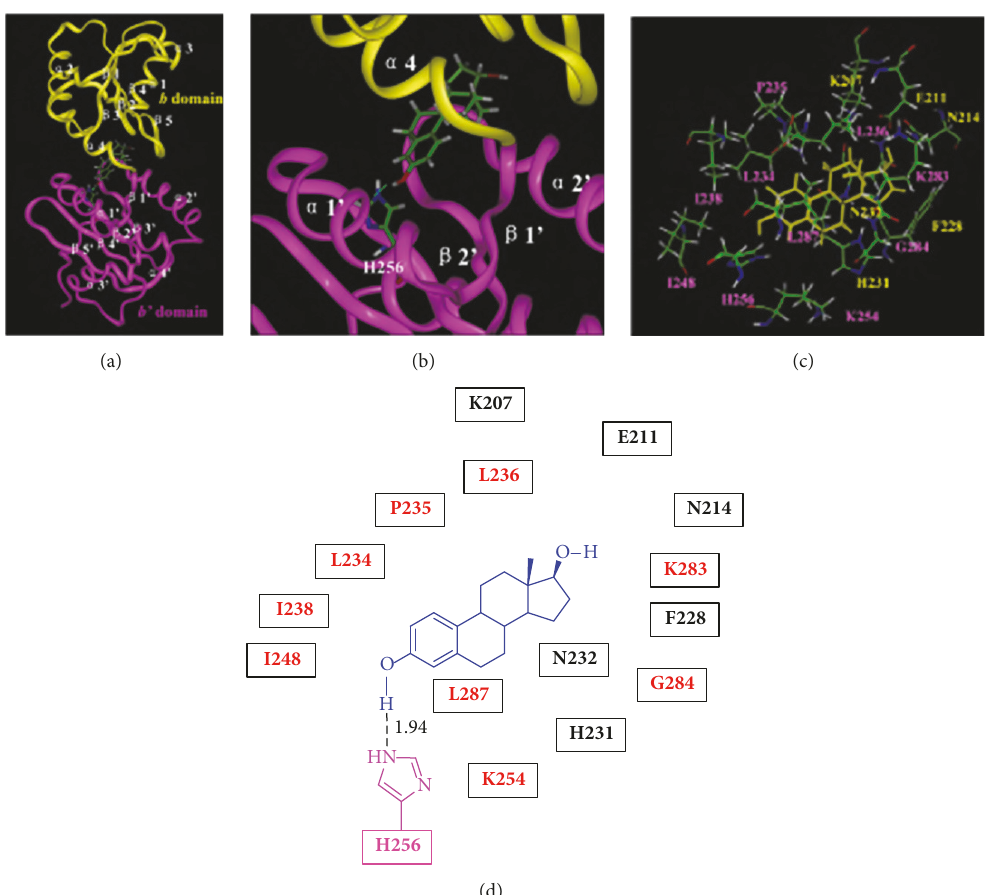
Figure 4: Docking analysis of the binding interaction of E 2 inside human PDI b-b 󸀠 fragment (Figure by Fu et al. [6]).